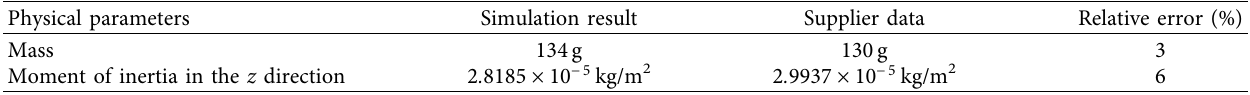
Figure 6: Finite element analysis of the spiral coupling. (a) Tension and compression in the z direction. (b) Bending around the y direction. Table 1: Physical parameters of the white coupling obtained by FE simulation versus the supplier’s given data.